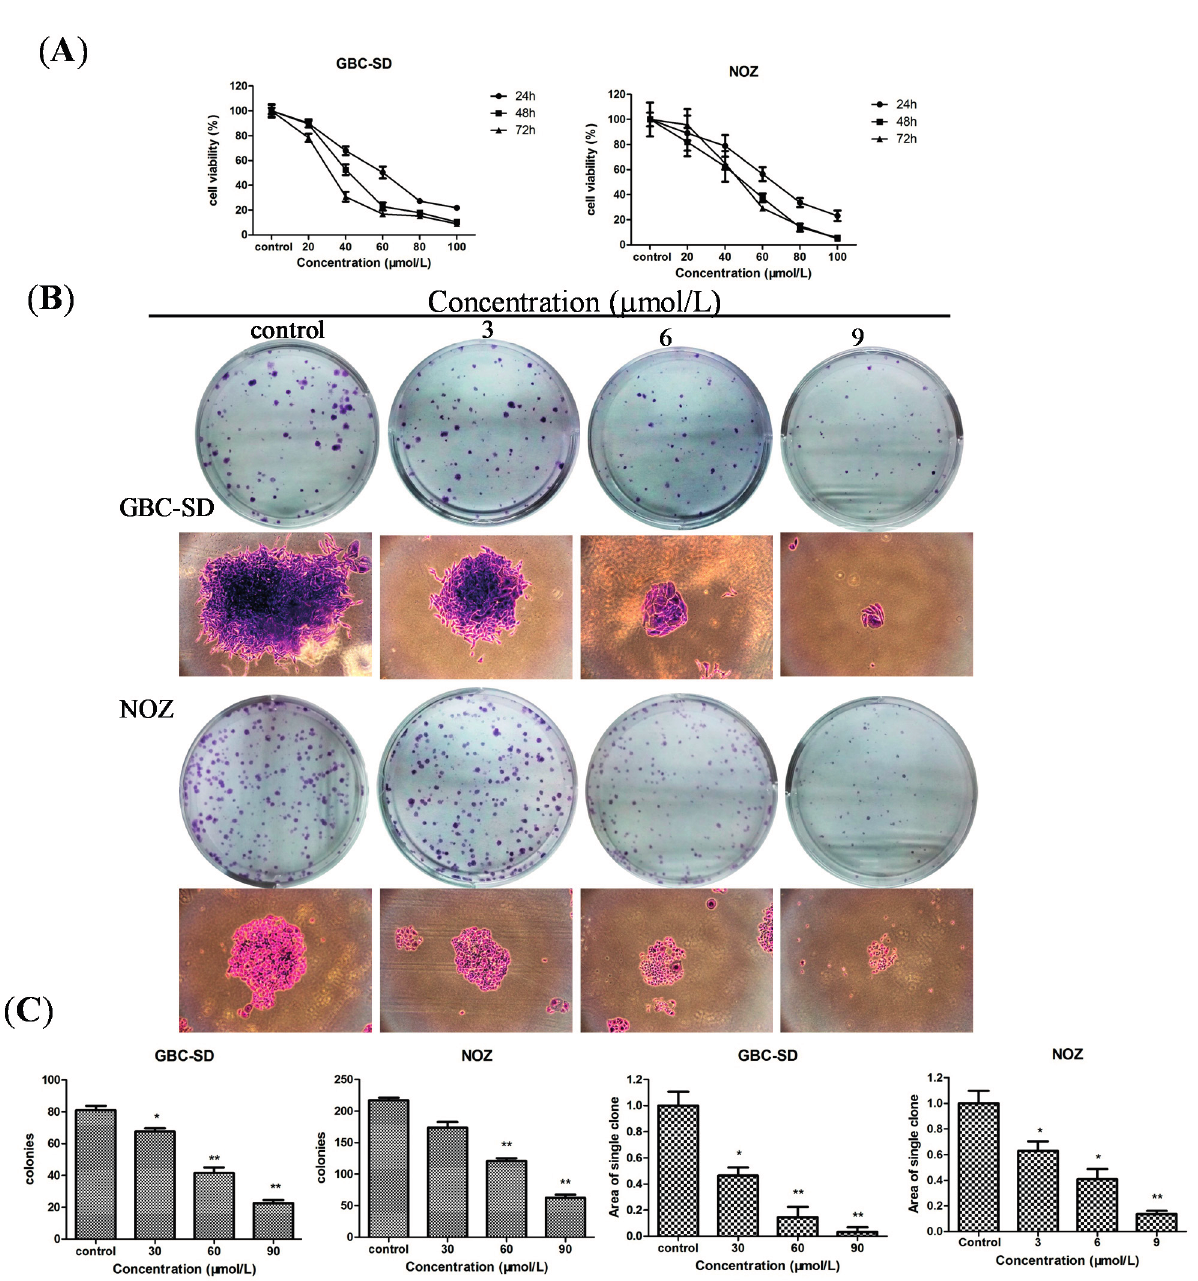
Figure 2. Sch B inhibits the proliferation and viability of gallbladder cancer cells. ( A ) GBC-SD and NOZ cells were treated with Sch B (0, 30, 60 and 90 μ mol/L) for 24, 48 and 72 h. Cell viability and IC50 were determined by MTT assay. ( B ) GBC-SD and NOZ cells were treated with various concentration of Sch B (0, 3, 6 and 9 μ mol/L) and were allowed to form colonies in fresh medium for 14 days. The photomicrographic differences and ( C ) influence of colonies (mean ± SD, n = 3) on colony formation are shown. All data were from three independent experiments. * P < 0.05, ** P < 0.01 vs . the control